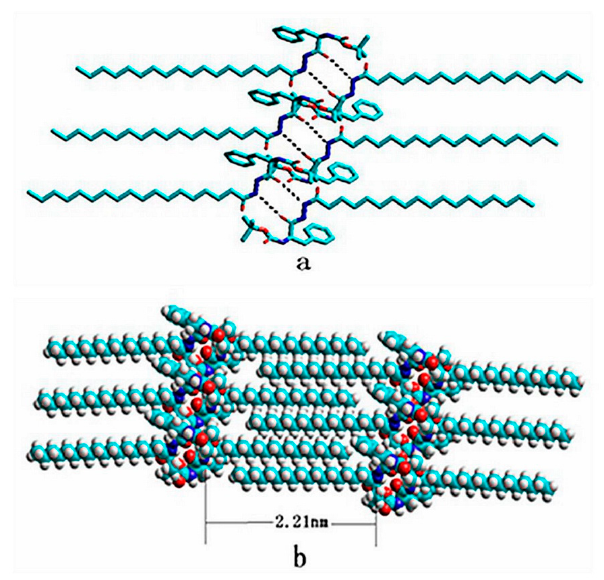
Figure 8. ( a ) The simulation diagram and the optimal structures of compound 4 and ( b ) the possible stacking modes for the aggregates in organic solvents. Dashed lines represent hydrogen bonding interactions.